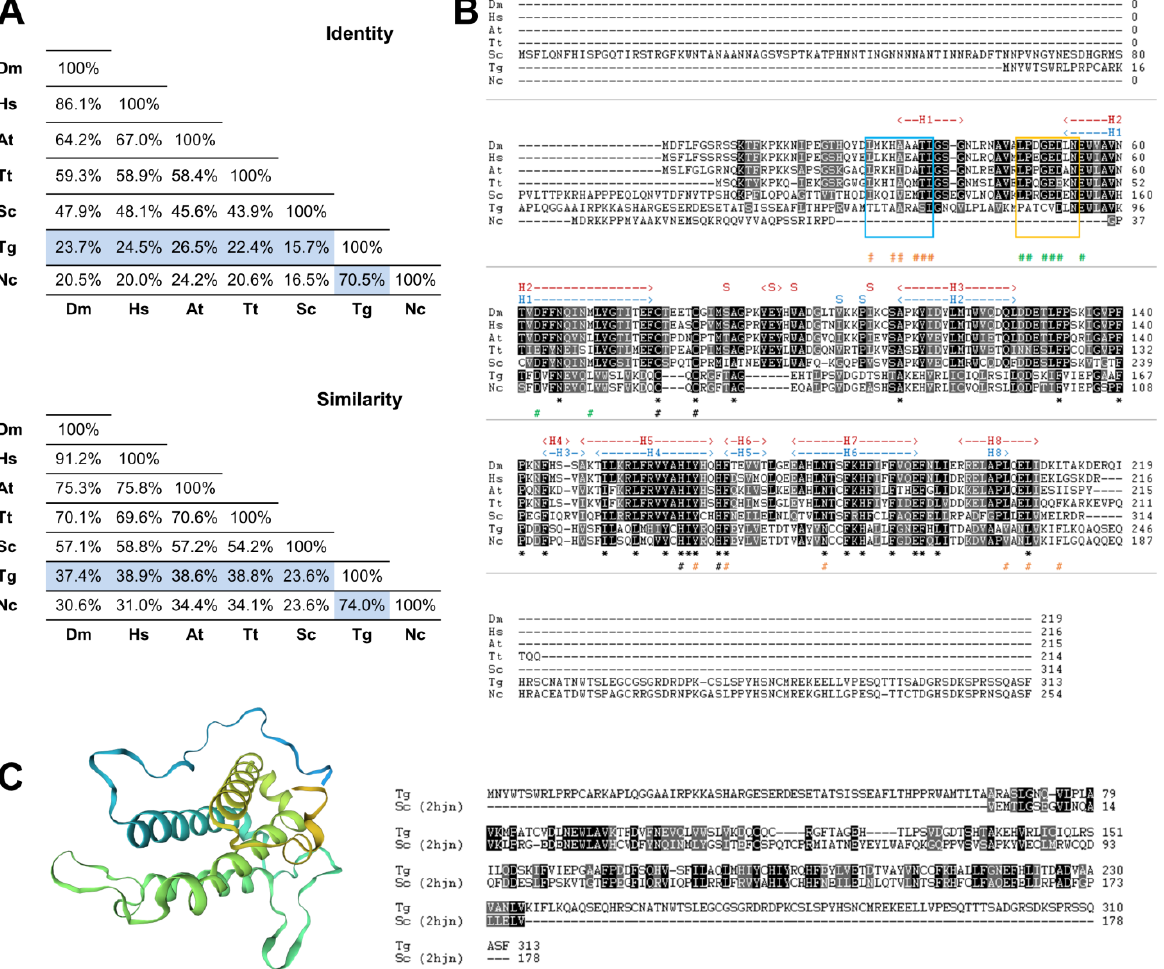
Figure 1. The Toxoplasma gondii MOB1 protein is highly conserved. The T. gondii MOB1 protein sequence was compared to other eukaryote MOB1 proteins. ( A ) Identity and similarity analysis of MOB1 proteins. The percentages of the T. gondii MOB1 versus other eukaryote MOB1 proteins assessed are highlighted in blue. ( B ) Alignment of MOB1 proteins. At the bottom of the alignment, asterisks (*) signal invariant residues. The conserved zinc-binding cysteine ( T. gondii C105 and C107) and histidine residues ( T. gondii H188 and H193) are indicated by a black # at the bottom. S. cerevisiae MOB1 residues that participate in the NDR–MOB1 interaction are indicated by a green # at the bottom [33]. The region of the NDR kinase binding motif LPXGED is highlighted by a yellow box [33]. ScMOB1 residues that participate in the MOB1 homodimer interaction are indicated by an orange # at the bottom [32]. The region of the ScMOB1 homodimer interaction-conserved residues integrating the helix H1 are highlighted by a light blue box [32]. The T. gondii MOB1 secondary structure, pre- dicted by the SWISS-MODEL, is indicated at the top of the alignment in dark blue. The ScMOB1 secondary structure is indicated at the top of the alignment in dark red [32]. ( C ) T. gondii MOB1 theoretical 3D model based on the ScMOB179- 314 structure (PDB h2jn) and corresponding sequence alignment. A rainbow color scheme from blue (N-terminus) to yel- low (C-terminus) is presented. Dm, Drosophila melanogaster ; Hs, Homo sapiens A; At, Arabidopsis thaliana A; Tt, Tetrahymena thermophila ; Sc, Saccharomyces cerevisiae ; Tg, Toxoplasma gondii ; Nc, Neospora caninum . In order to investigate the evolutionary relationship between MOB1 proteins from different organisms, we performed a phylogenetic analysis, including parasites as well as model organisms (Figure 2). The first node separates animals from two other groups: (i) the group containing plants and unicellular organisms such as microalgae ( Chlamydomo- nas reinhardtii ) and ciliates ( T. thermophila , Stentor coeruleus ); and (ii) the group containing the remaining organisms. Focusing on the unicellular organisms included in the phyloge- netic analysis, we observe that free-living and parasitic organisms are in different clades of the tree. Regarding parasitic organisms, a distinction between the Trypanosoma and Leishmania species, which belong to the supergroup Excavata, and parasites belonging to